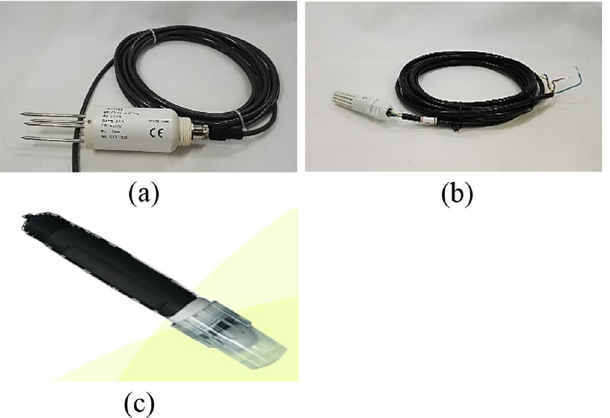
Figure 1. Illustration of the sensors used in this study: ( a ) CSH-11 soil moisture sensor, ( b ) SHT-10 air temperature and humidity sensor, and ( c ) JASP2801 pH